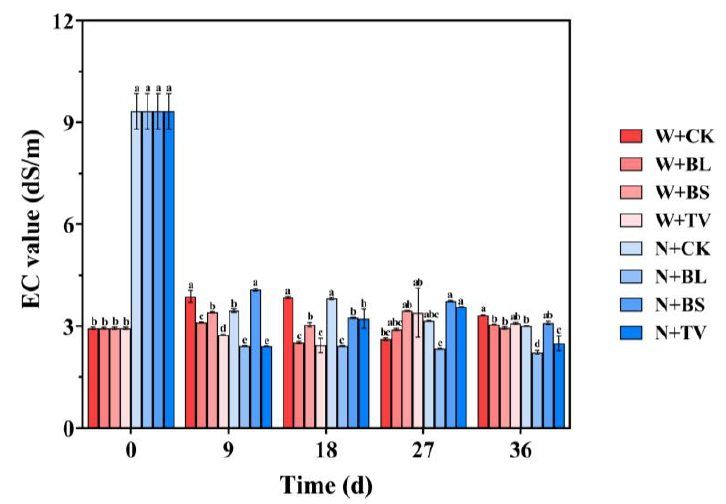
Figure 3. Changes in EC values in the treatments. Means ± SEs with different letters in each parameter indicate significant statistical differences ( p < 0.05).